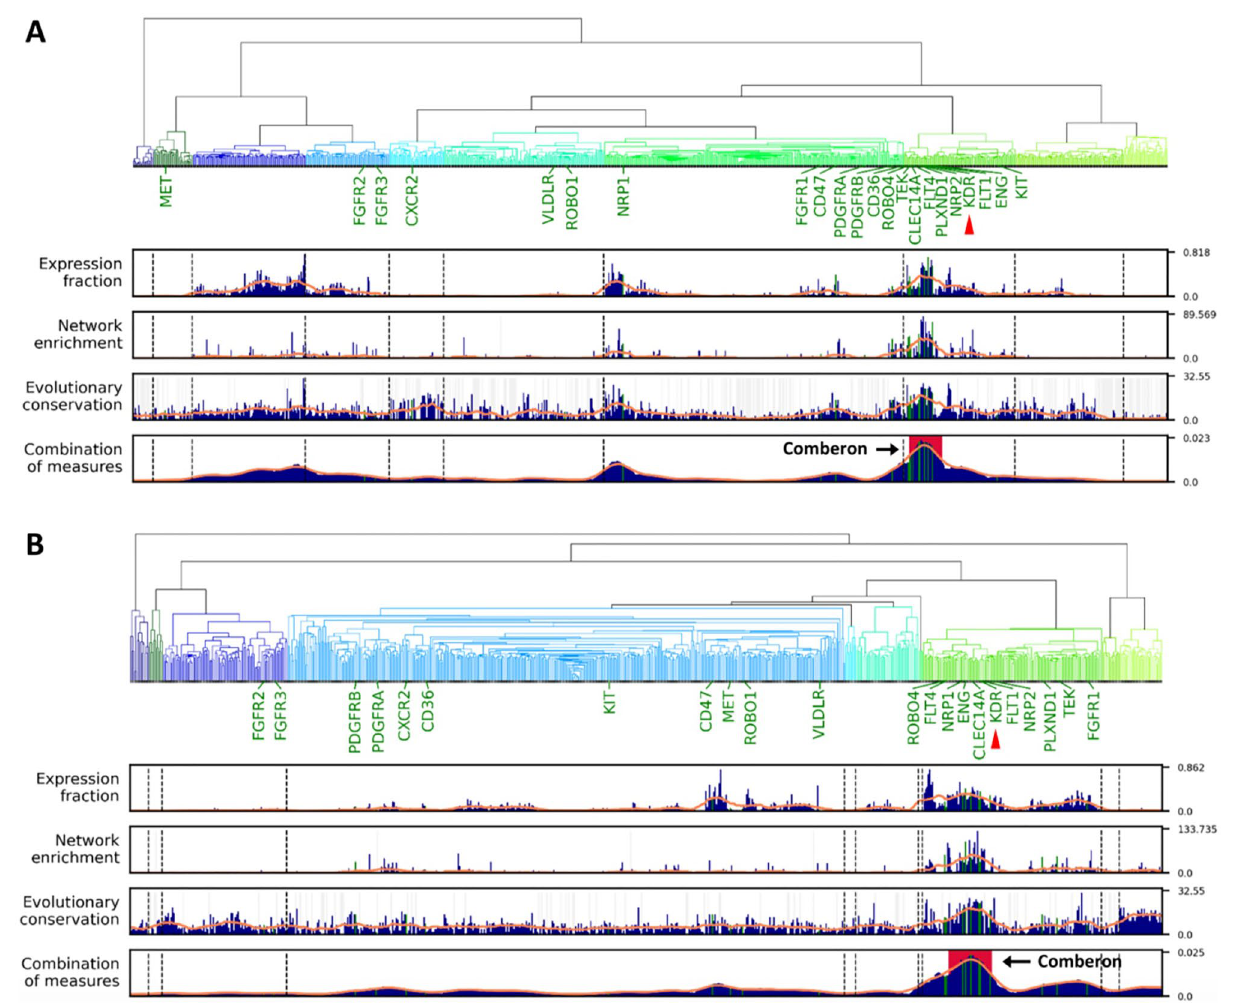
Figure 2. Dendrogram analysis identifies naturally occurring combinations of angiogenesis receptors in endothelial cells. The top of panels ( A ) and ( B ) displays the dendrogram ordering by single cell co-expression of receptors in endothelial cells for: ( A ) Mus musculus and ( B ) Homo sapiens . Receptors that are co-expressed in individual cells are closer to each other in the dendrogram order. Known angiogenesis receptors are labeled under the dendrogram. The red pointer indicates KDR, the main VEGFA receptor. The panels immediately below the dendrogram show three measures: Expression fraction, Network enrichment and Evolutionary conservation. The lowest panel shows the combination of these three measures. The solid orange line in each panel is a moving window average. The largest peak in the combination of measures panel, representing the main comberon (abbreviation for naturally occurring combination) is shown with a red frequency. The bootstrap method performs 100 partial resamples and the frequency indicates how many resam- ples contain the receptor within the main peak (comberon) shown in Fig. 2, with a frequency of 1 corresponding to 100%. We used a hypergeometric test for the top genes from the mouse bootstrap shown in Table 1. There are 7 known angiogenesis receptors in this set, which gives a p value of 5 · 10 − 8 . As negative controls we used 30,836 sets of genes from the GO Biological Process class (see Table S2). Table S2 shows that the only strongly significant associations are with terms related to angiogenesis. Receptors with Mus musculus PanglaoDB bootstrap frequencies of at least 0.5 are included in Table 1. A permutation test allowed us to obtain a non-parametric estimate of the probability of obtaining a frequency above 0.5 in Mus Musculus as p < 10 − 7 . This test shows that the bootstrap method used is extremely unlikely to identify genes with a frequency higher than 0.5 in the absence of co-expression. A lower probability set ( p < 0.05) can also be identified by including bootstrap frequency values between 0.33 and 0.5. This includes an additional nine genes shown in column 1 of Table S3. The conservation between mouse and human receptors in the main endothelial comberon, shown in bold with a yellow background in Table 1, was also analyzed with the hypergeometric test and was clearly significant ( p < 10 − 23 ).